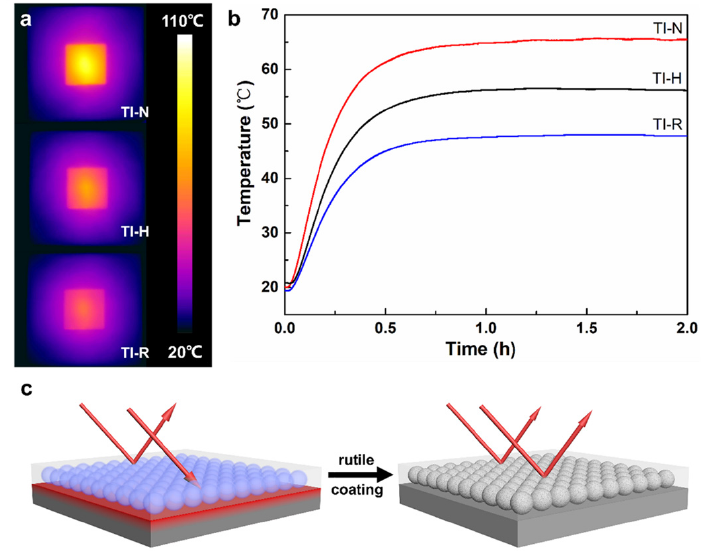
Figure 8. ( a ) IR images of the outer surface of different coatings on the gypsum board after 2 h infrared illumination; ( b ) the recorded temperature curves of the inner surface of the gypsum board with different coatings; ( c ) schematic illustration of the enhancement of NIR-reflective thermal insulation performance of rutile-coated HGM.